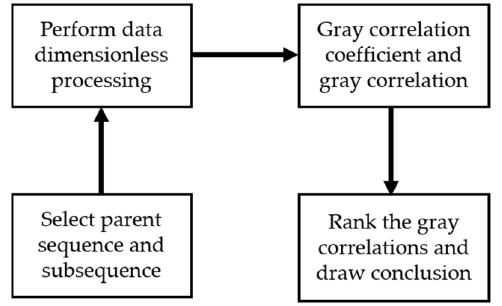
Figure 9. Flow chart of grey correlation analysis.